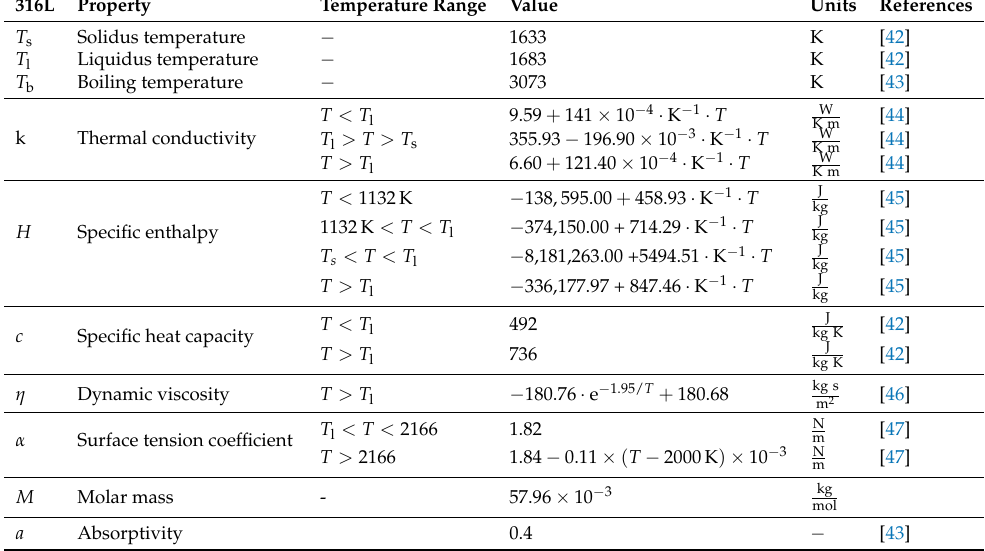
Table A1. Material properties of 316L for the